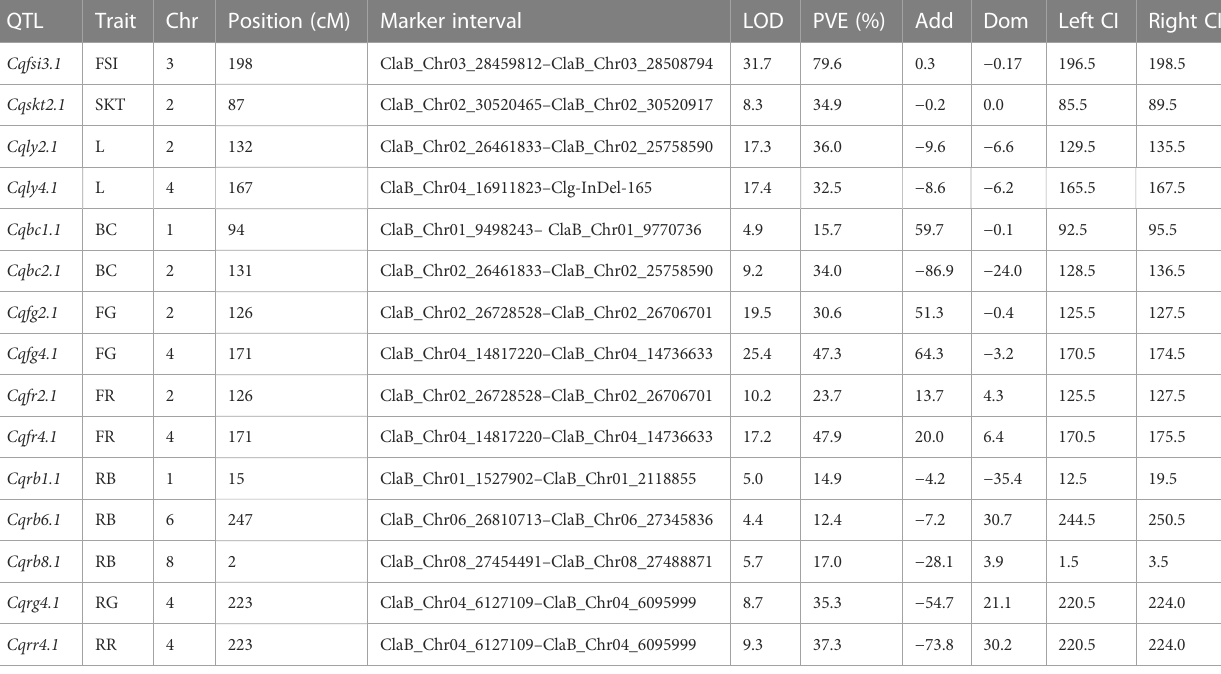
TABLE 3 Characteristics of the fruit quality-related QTLs in the watermelon (LOD > 4.3).